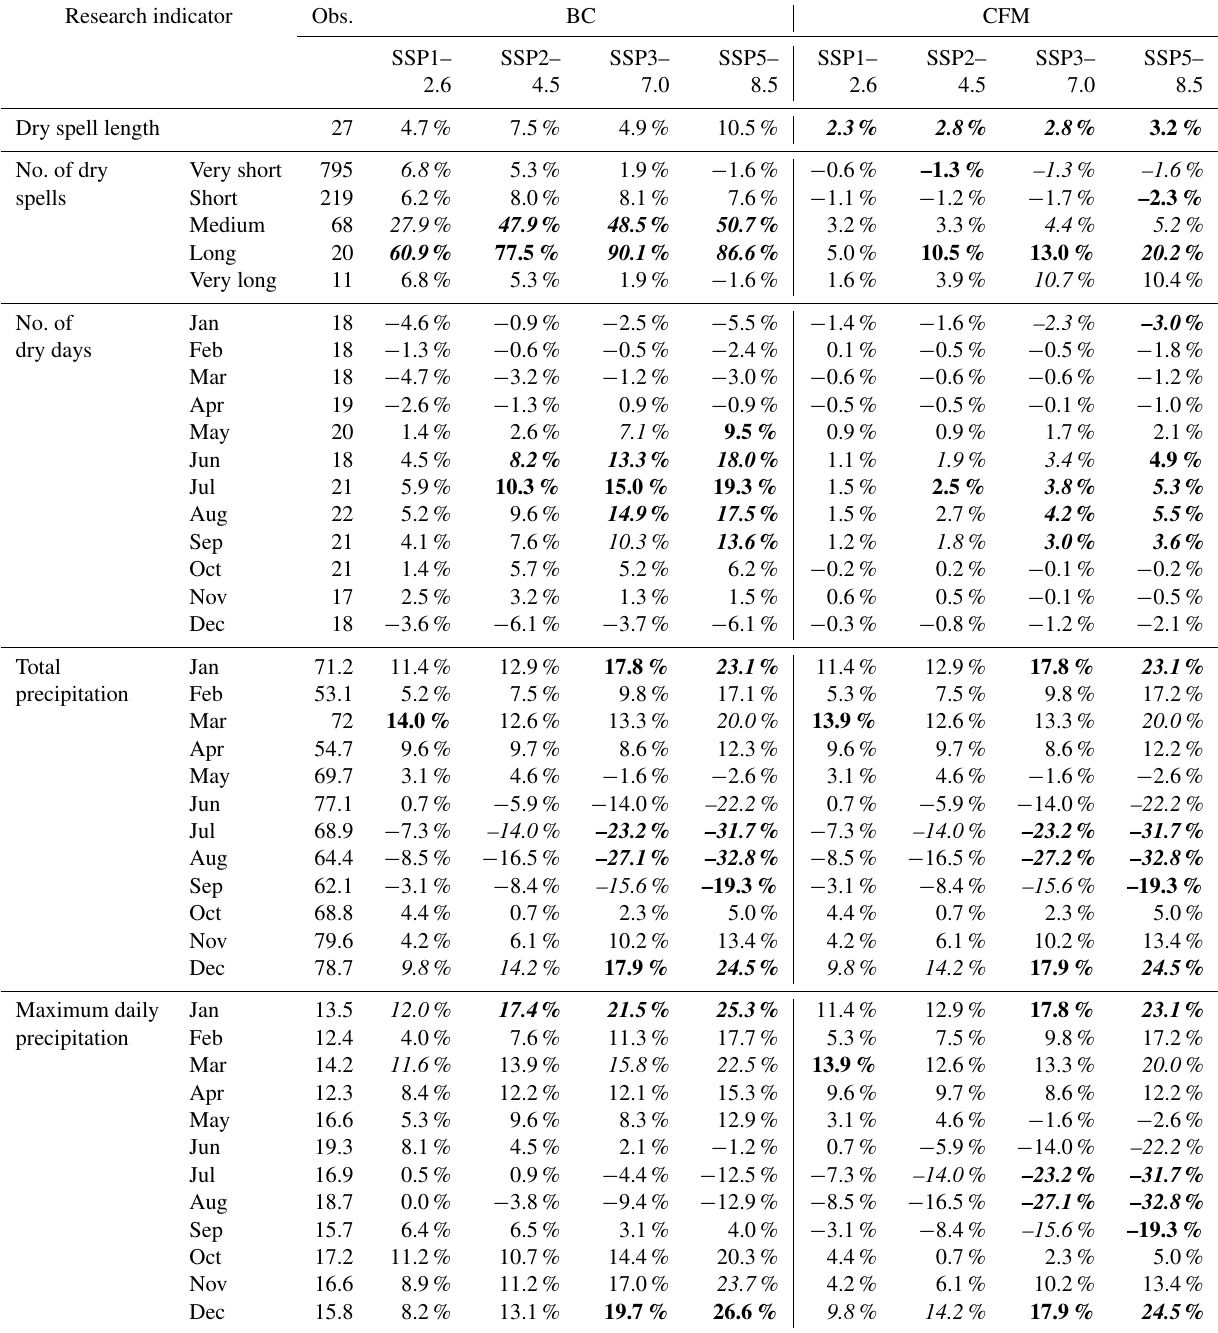
Table 5. Climate change signals and the corresponding significance for BC and CFM. Climate change signal is the change relative to the historical observations (1971–2000). Numbers in italic, bold and bold italic denote significant changes at 20%, 10% and 5% levels,